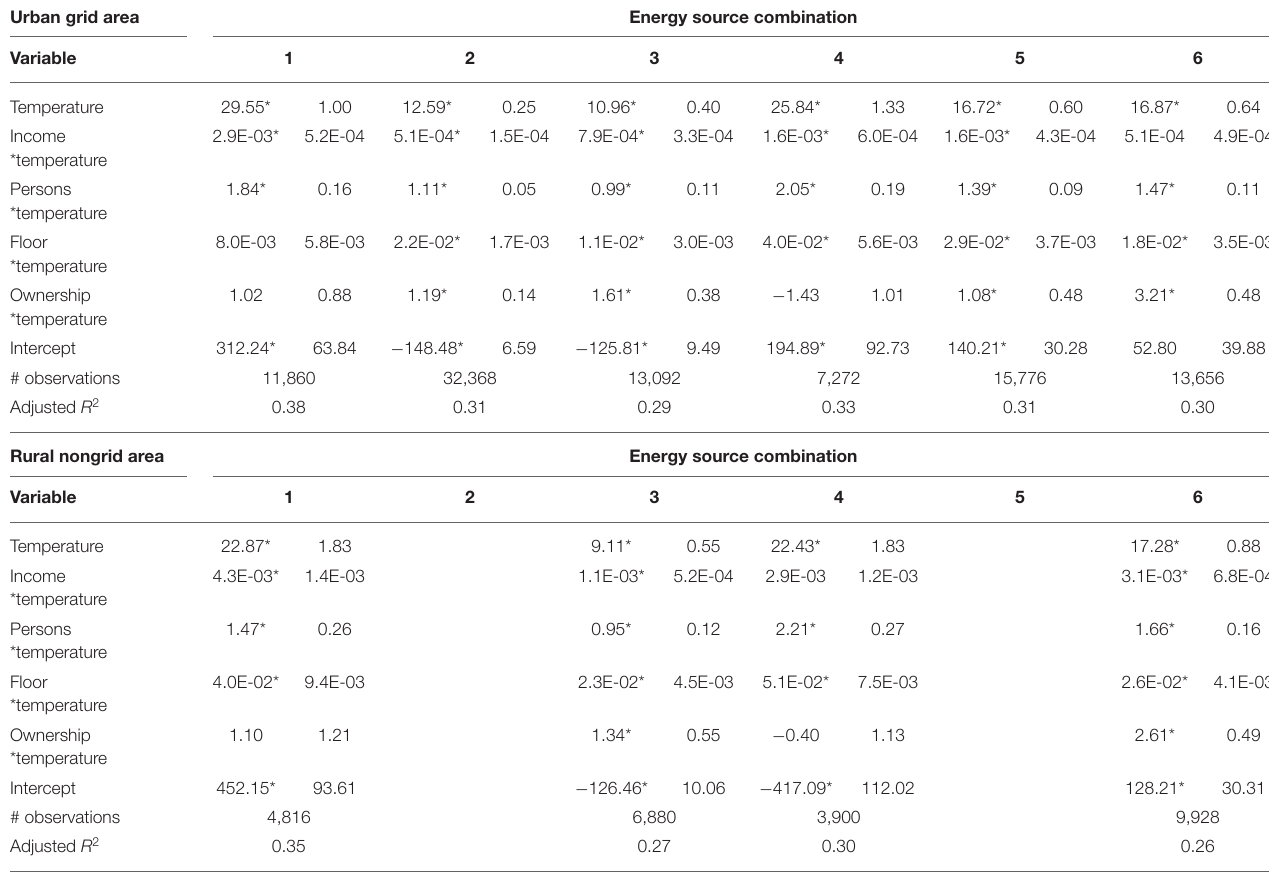
TABLE 4 | Determinants of winter CO 2 emissions. Urban grid